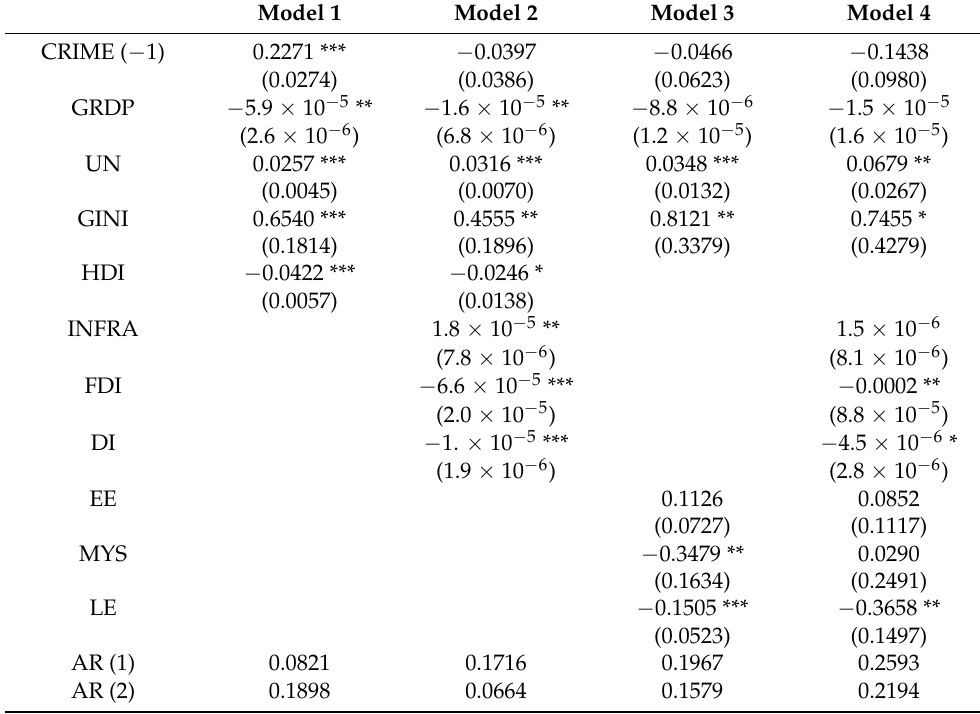
Table 3. Estimation results of total